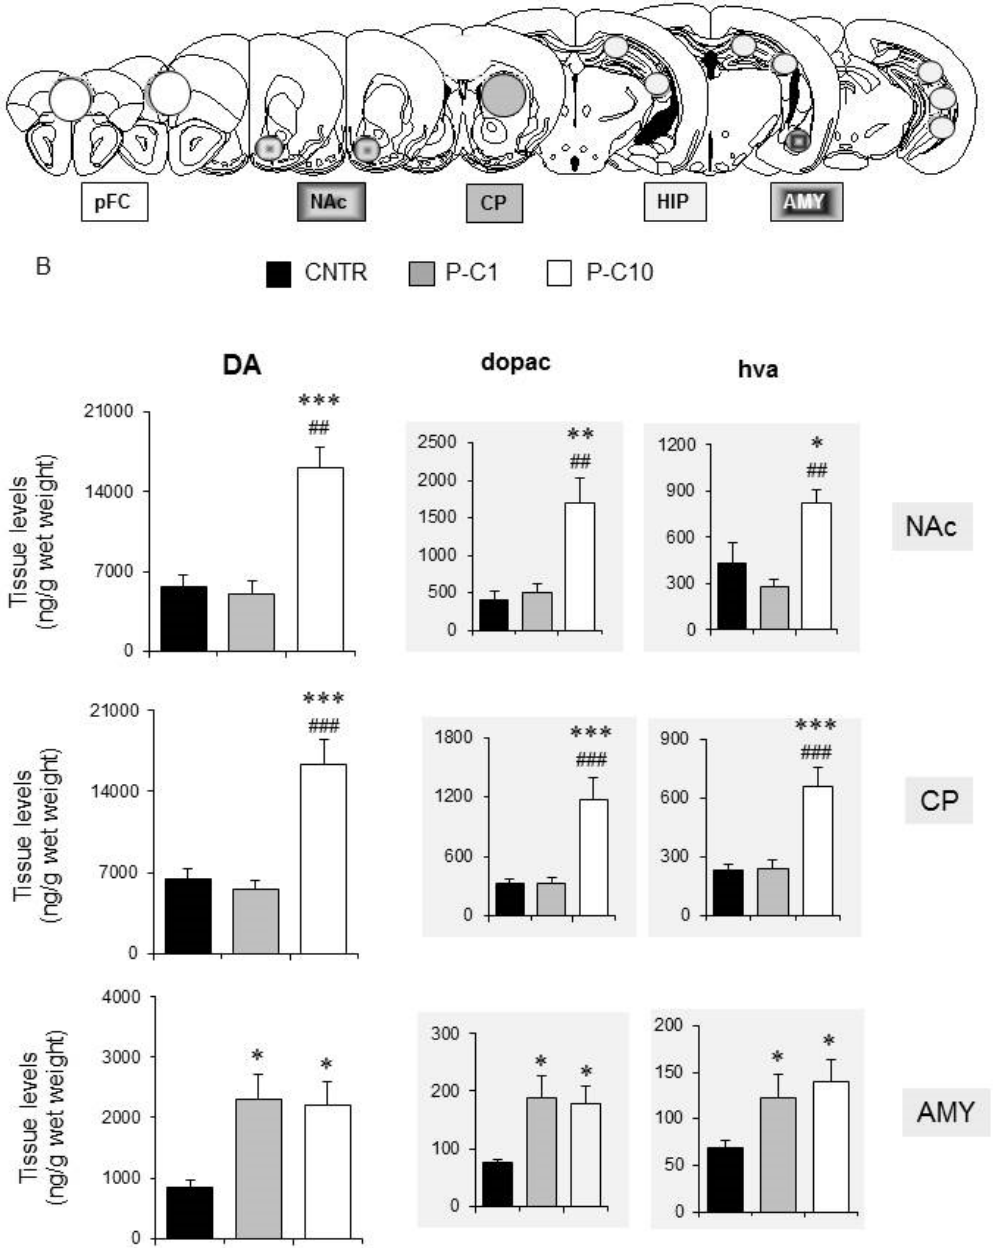
Figure 2. P-cresol enhances tissue levels of dopamine and its metabolites in the amygdala, caudate putamen and nucleus accumbens of BTBR mice. ( A ) Tissue levels of DA, DOPAC, HVA, NE, 5-HT and 5-HIAA, measured in medial pFC, NAc, CP, HIP, AMY. ( B ) Tissue levels of DA, DOPAC, HVA, measured in NAc, CP and AMY. CNTR, n = 9–10; P-C1, n = 6, P-C10 n = 6. Data are expressed as mean ± sem ng / g wet weight. *, **, *** p < 0.05, 0.01, 0.001 P-C1 or P-C10 vs. CNTR group. ## , ### p < 0.01, 0.001 P-C10 vs. P-C1 (treatment e ff ect) by Duncan’s post-hoc test following one-way ANOVAs. Abbreviations: AMY: Amygdala; CP: Caudate Putamen; DA: dopamine; DOPAC: 3,4-Dihydroxyphenylacetic acid; HIP: Hippocampus; HVA: Homovanillic acid; NAc: Nucleus Accumbens; pFC: preFrontal Cortex.